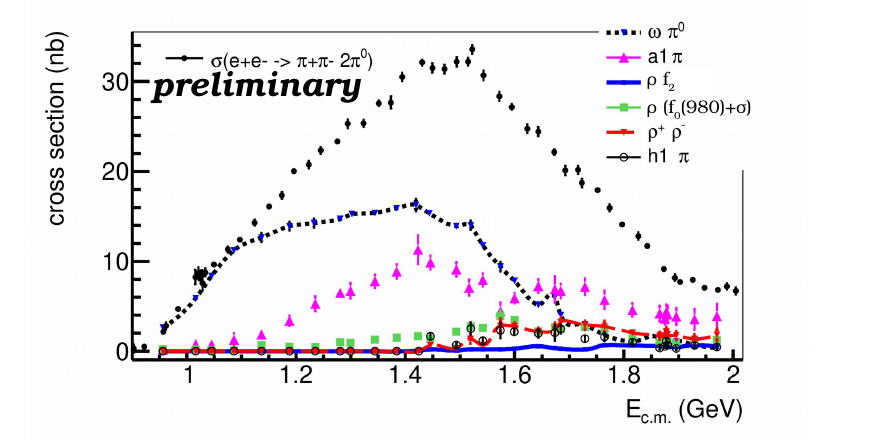
Figure 3. Cross sections calculated for di ff erent components of the matrix element. The total cross section of the process e + e − → 2 π 0 π + π − , measured in this analysis (filled circles).